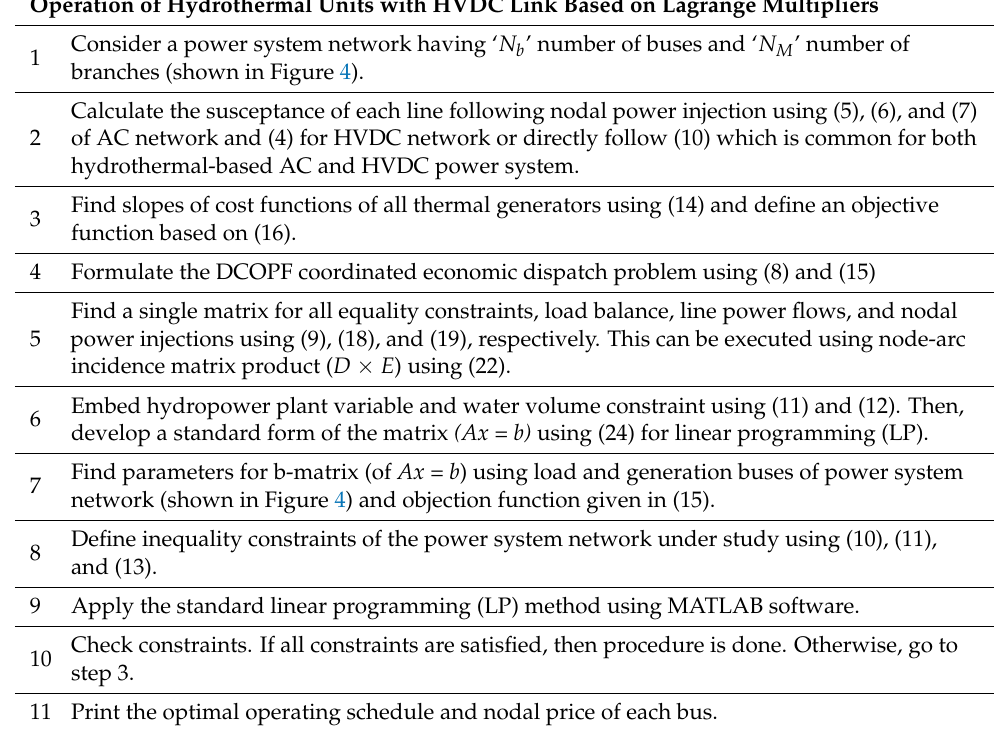
Table 1. Step-by-step implementation of proposed procedure. Step-by-Step Implementation of Proposed Procedure for Coordinated/Optimal